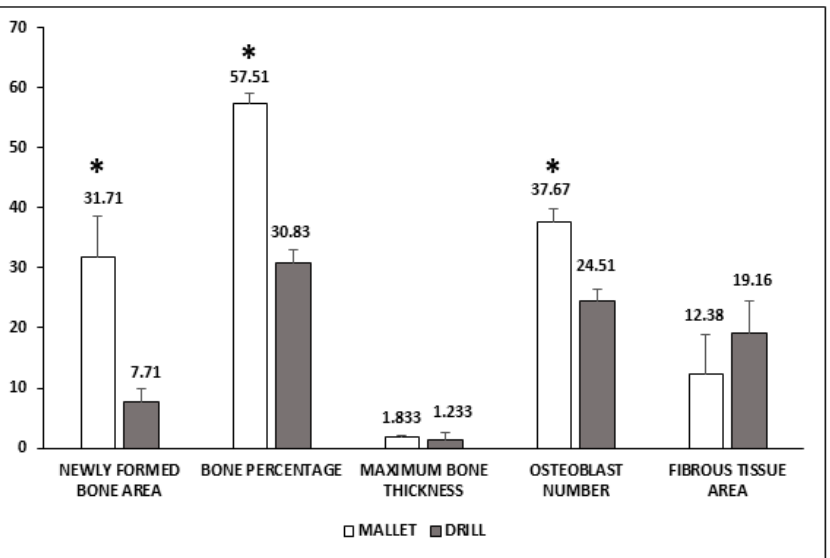
Figure 3. Histological evaluation of peri-implant bone tissues. Areas of newly formed bone and fibrous tissues are expressed as mm 2 and have been evaluated using an imaging computer software. Maximum bone thickness is expressed as mm and was evaluated, as the osteoblast number, by optical microscopy. Data represent the mean ± SEM of the evaluations carried out on bone samples obtained at T14. Student’s t -test: Newly Formed Bone Area * p = 0.031; Bone Percentage * p = 0.001; Osteoblast number * p = 0.009.